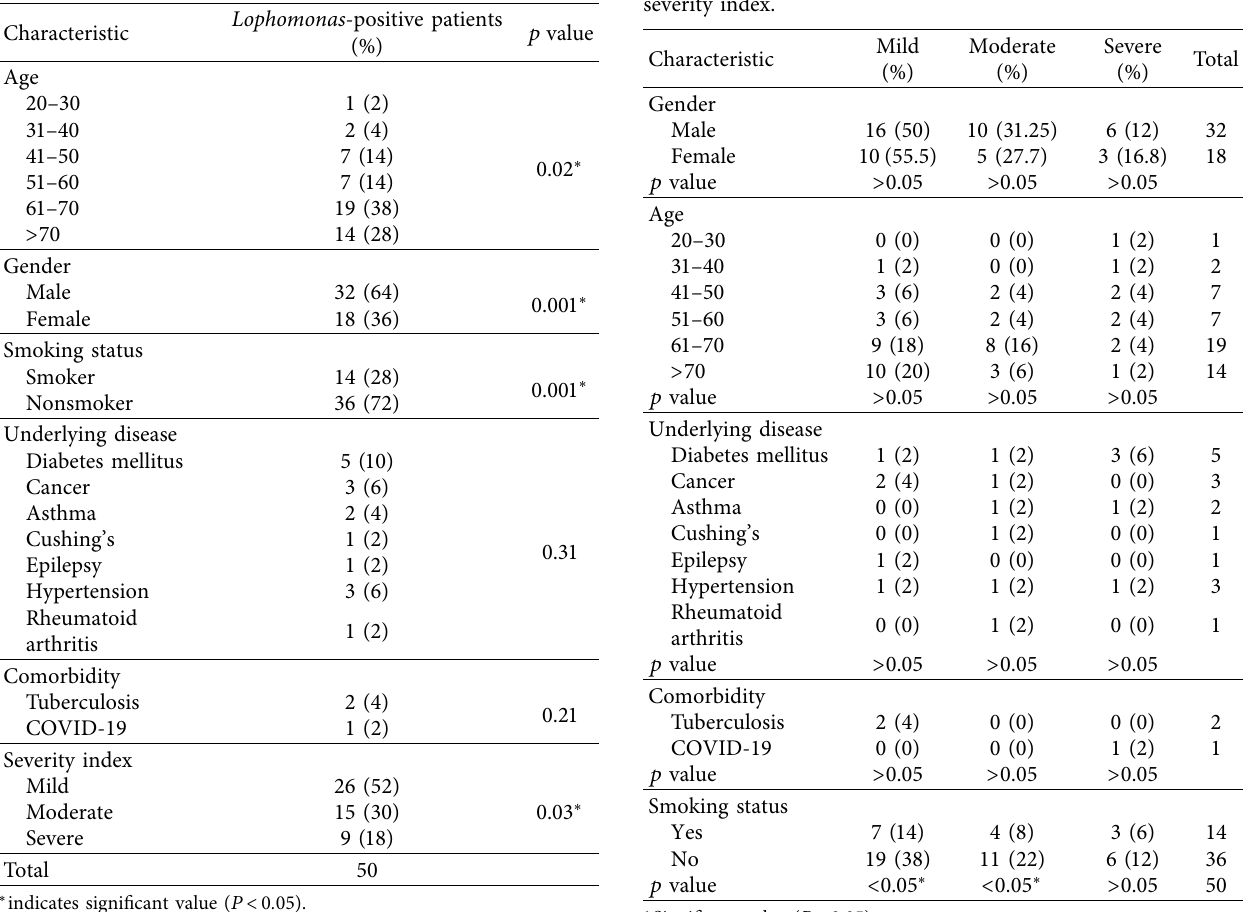
Figure 1: Direct smear of the bronchoalveolar lavage fluid (BALF) specimen with mild (a) and moderate (b) severity indices represents Lophomonas trophozoite (arrow ahead). Table 1: Demographic findings and characteristics of patients with Lophomonas infection referred to INRCL.